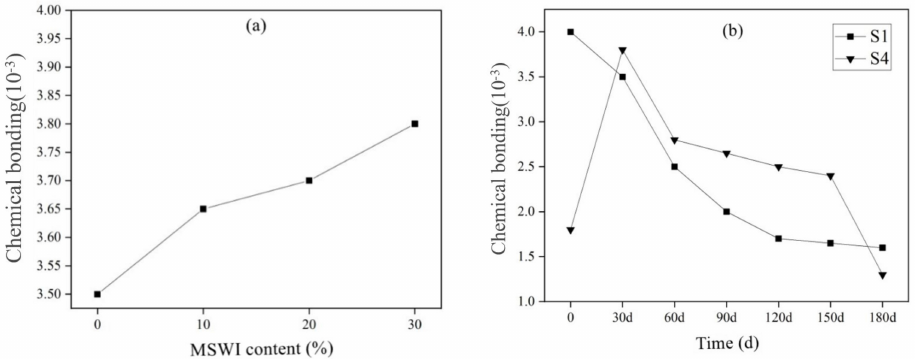
Figure 11. Chloride ion chemical bonding amount of MSWI recycled cement-based material at different dosage ( a ) and age ( b ).